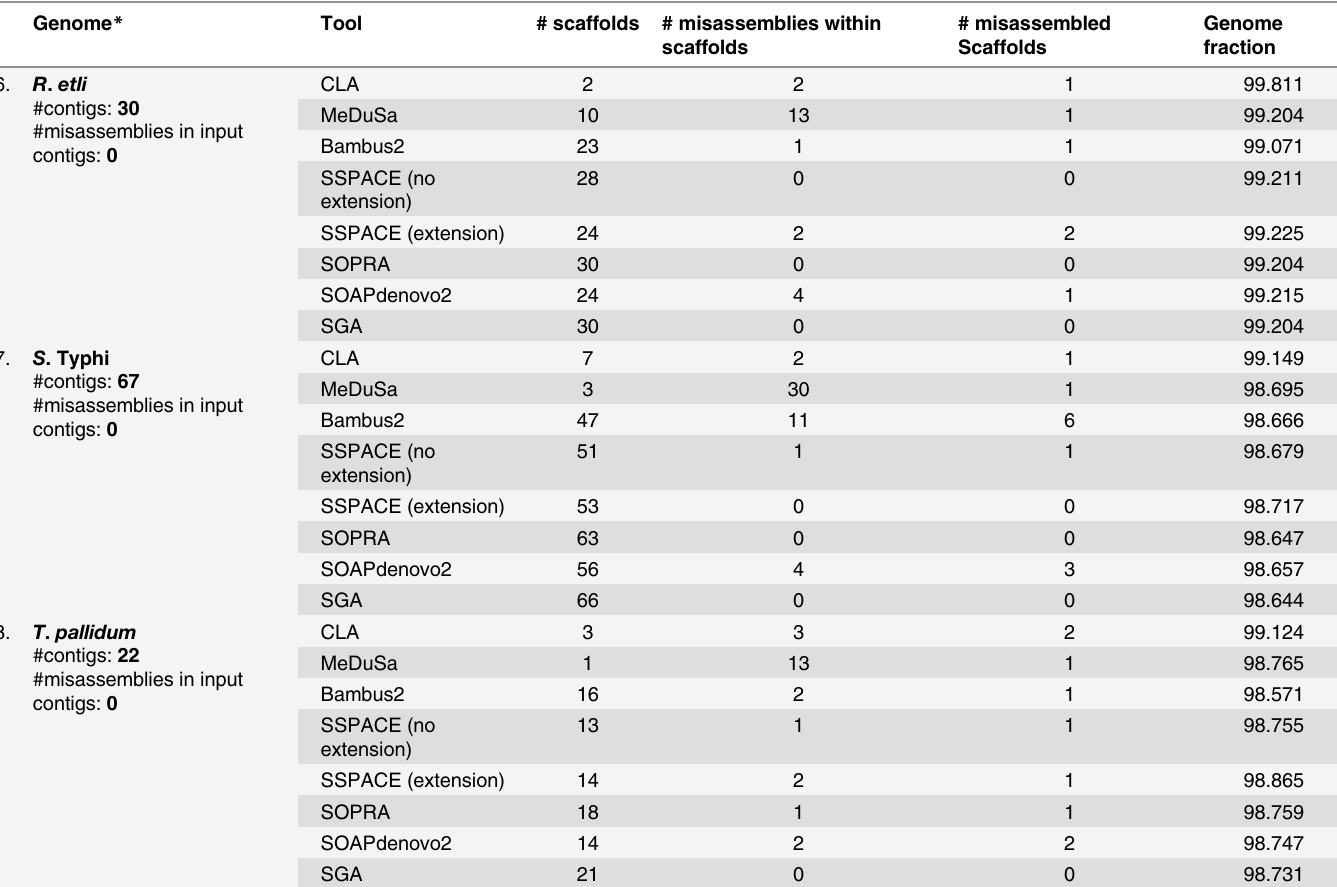
scaffolds whereas MeDuSa, Bambus2, SSPACE with extension, SSPACE without extension, SOPRA, SOAPdenovo2 and SGA generated 10, 23, 24, 28, 30, 24 and 30 scaffolds, respectively. CLA ’ s performance was consistent for all the genomes under comparison except in H . pylori where the number of misassemblies slightly increased to 7. In C . jejuni , 33 contigs were com- bined by CLA into 6 scaffolds without any misassemblies. In B . quintana , C . crescentus and S . Typhi, only 2 inversions were found within scaffolds from CLA (S4 Table). Numbers of misas- semblies performed by CLA were relatively fewer when compared with MeDuSa even in the real dataset (Table 4). Though MeDuSa generated a lesser number of scaffolds in a few cases of both the real and simulated datasets, the number of misassemblies was significantly higher in all the organisms. While misassemblies in case of SSPACE, SOPRA and SOAPdenovo2 were more or less similar to that of CLA, these tools gave a higher number of scaffolds. Considering the trade-off between number of scaffolds generated and the number of misassemblies, CLA showed the best performance with least number of scaffolds having the minimum misassemblies and the highest genome fraction